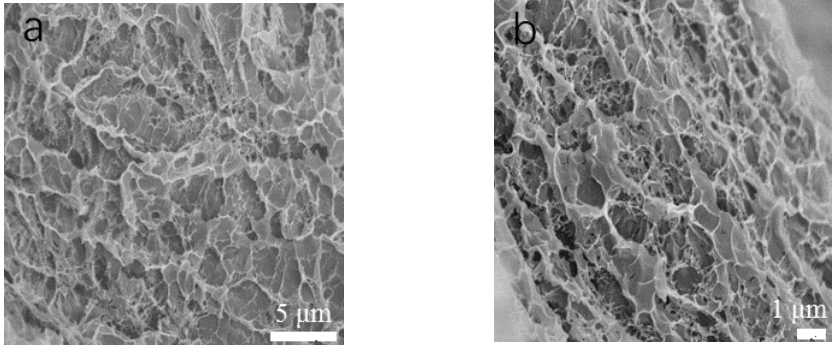
Figure 6. SEM images of aerogel (AP–RD/GO–CT (20%)) ( a ), high magnification SEM of aerogel (AP–RD/GO–CT (20%)) ( b )